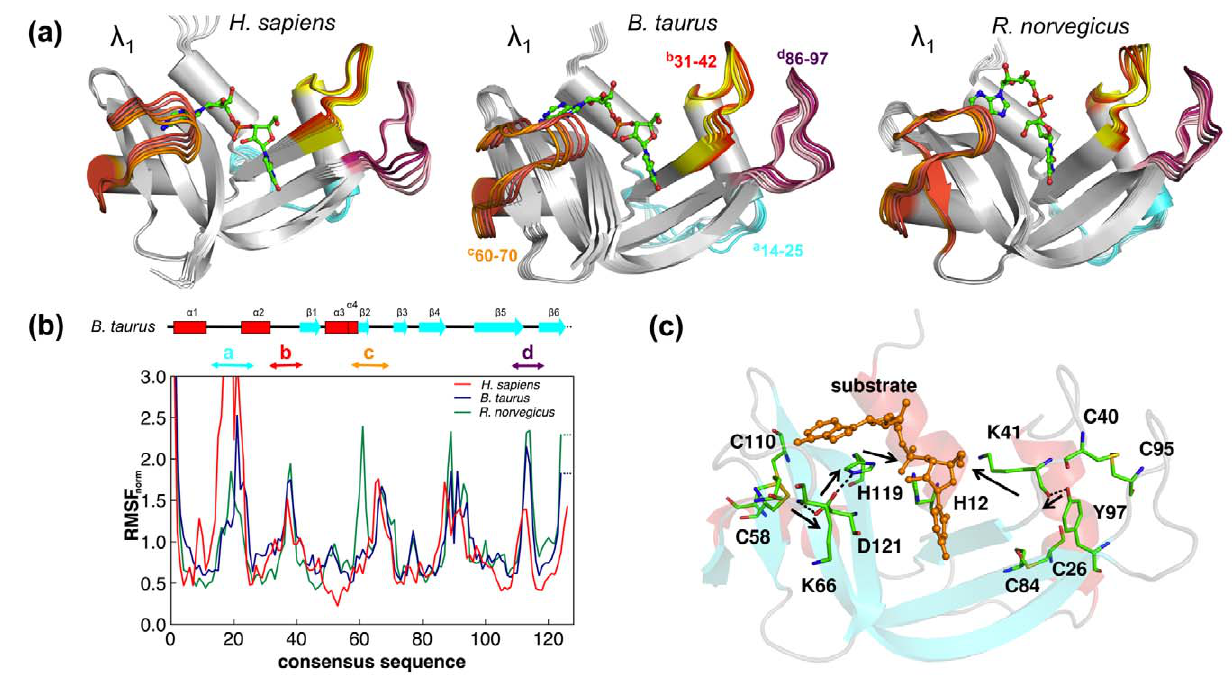
Figure 5. Conservation of reaction-coupled flexibility in enzyme RNaseA across three species. (a) Slowest mode coupled to RNA hydrolysis shows large fluctuations in the same regions (near and away from the active-site) of the enzyme from three species. (b) Enzyme backbone flexibility depicted as normalized RMSF. (c) Conservation of the network interactions (black arrows) connecting the flexible regions as a part of the RNaseA fold (only B. taurus RNaseA is shown). The modes are depicted/colored and the RMSF is normalized similarly to the CypA results.